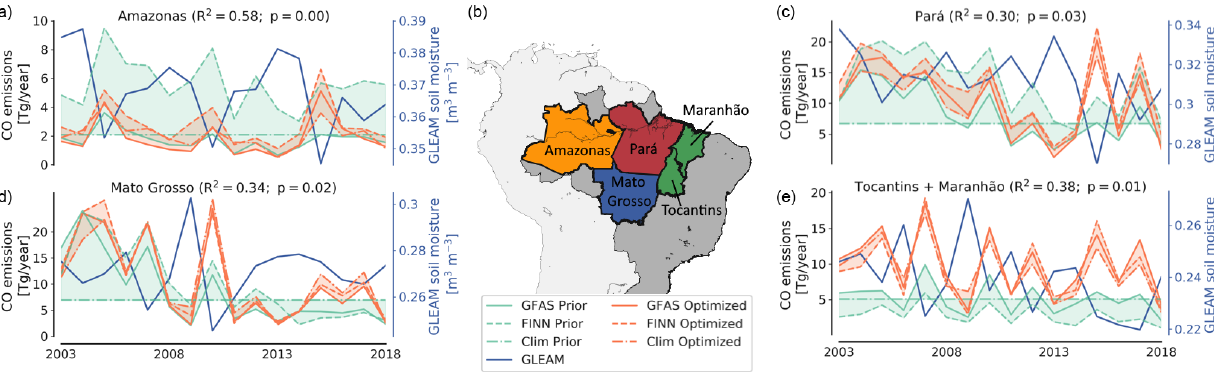
Figure 3. Interannual variability in the area-average soil moisture and fire CO emissions in five Brazilian states. The four outside pan- els (a, c, d, e) show the 2003–2018 time series of May–December total CO emissions from biomass burning (left axis, in orange and green) and the annual averaged root-zone soil moisture from the Global Land Evaporation Amsterdam Model (GLEAM v3.3a) product (right axis, in blue), for five Brazilian states. A year is defined here as June–December (i.e. centred on the dry season). Both prior (green) and MOPITT- optimized (orange) fire CO emissions are shown, for the three inversions that start from different prior fire inventories (indicated by solid, dashed, and dot-dash lines). Shaded areas indicate the spread between the fire inventories before (green) and after (orange) the inversion. Also shown at the top are the correlation coefficients ( R 2 values) between CO emissions and soil moisture for the optimized emissions from the inversion that start from the GFAS inventory. Maranhão and Tocantins are combined, as they are smaller states that represent similar regimes in terms of climate and anthropogenic activity. Note the different y scales between the four figures, with the lowest emissions in Amazonas. Panel (b) shows a map of these five Brazilian